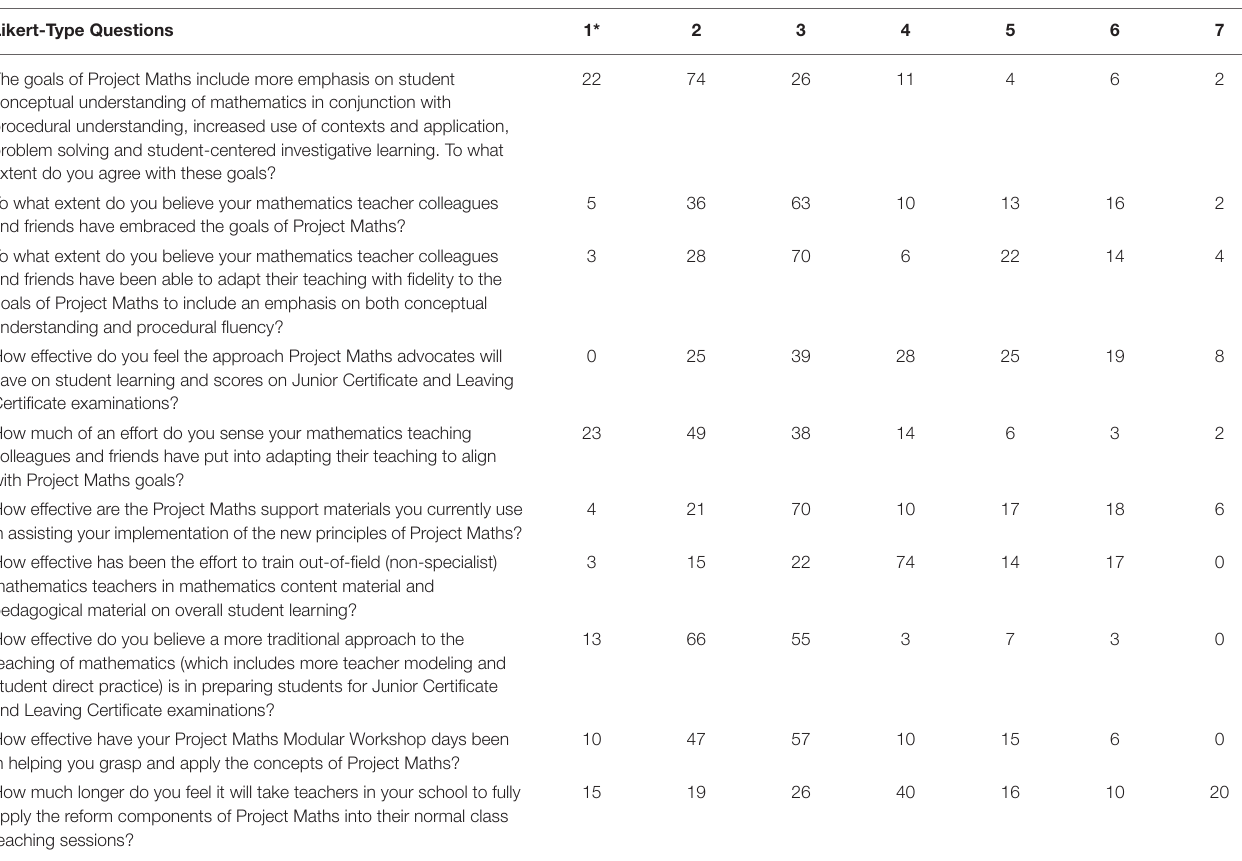
TABLE 4 | Likert-type survey questions and frequency of